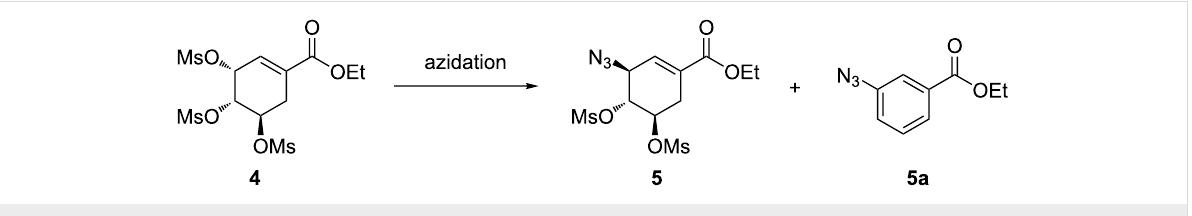
DMSO as solvent made the product isolation more